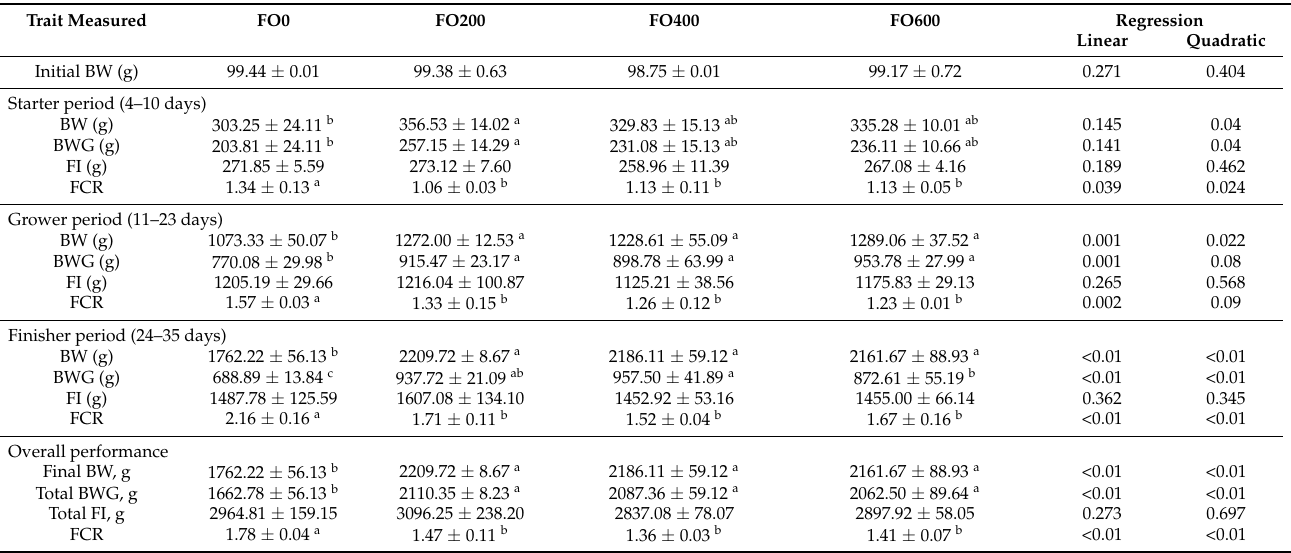
Table 3. Effects of Dietary FO Supplementation on Growth Performance of Broiler Chickens During the Feeding Periods.